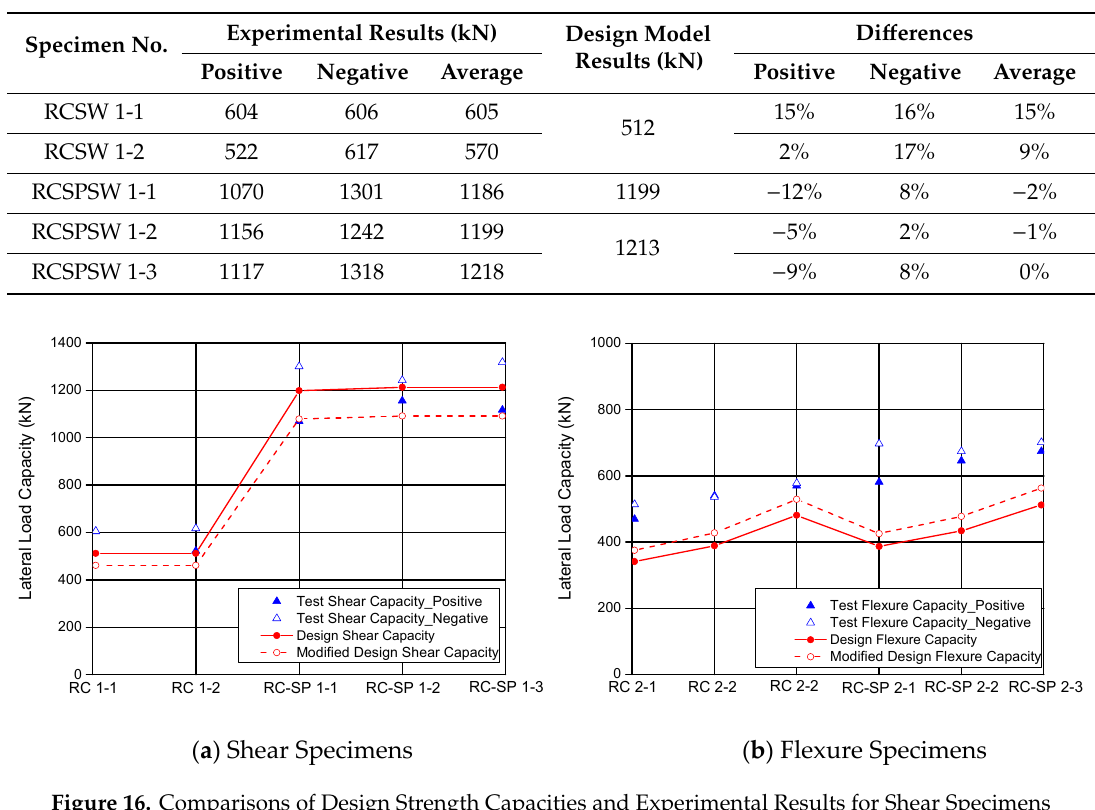
Figure 16. Comparisons of Design Strength Capacities and Experimental Results for Shear Specimens and Flexure Specimens.